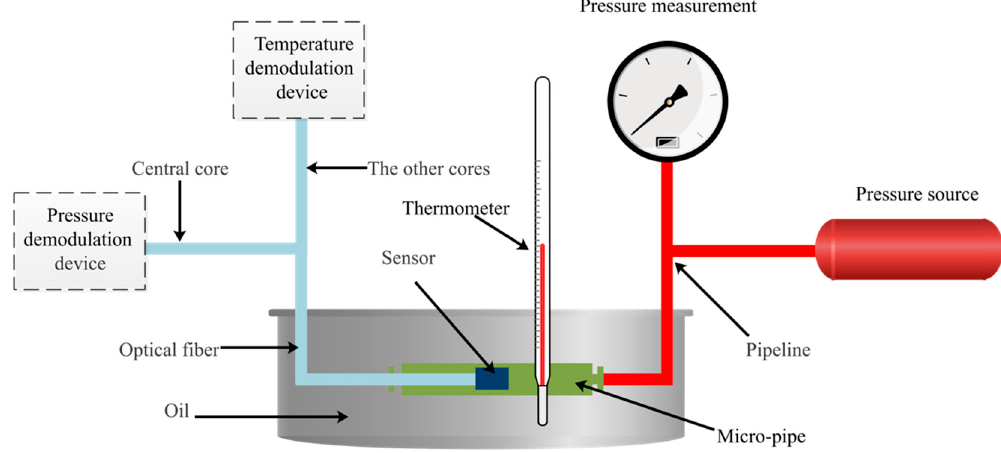
Figure 7. Experimental setup for testing sensor performance.